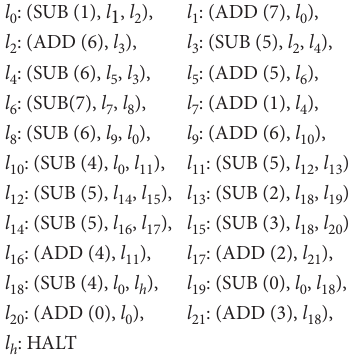
Figure 6: The universal register machine M